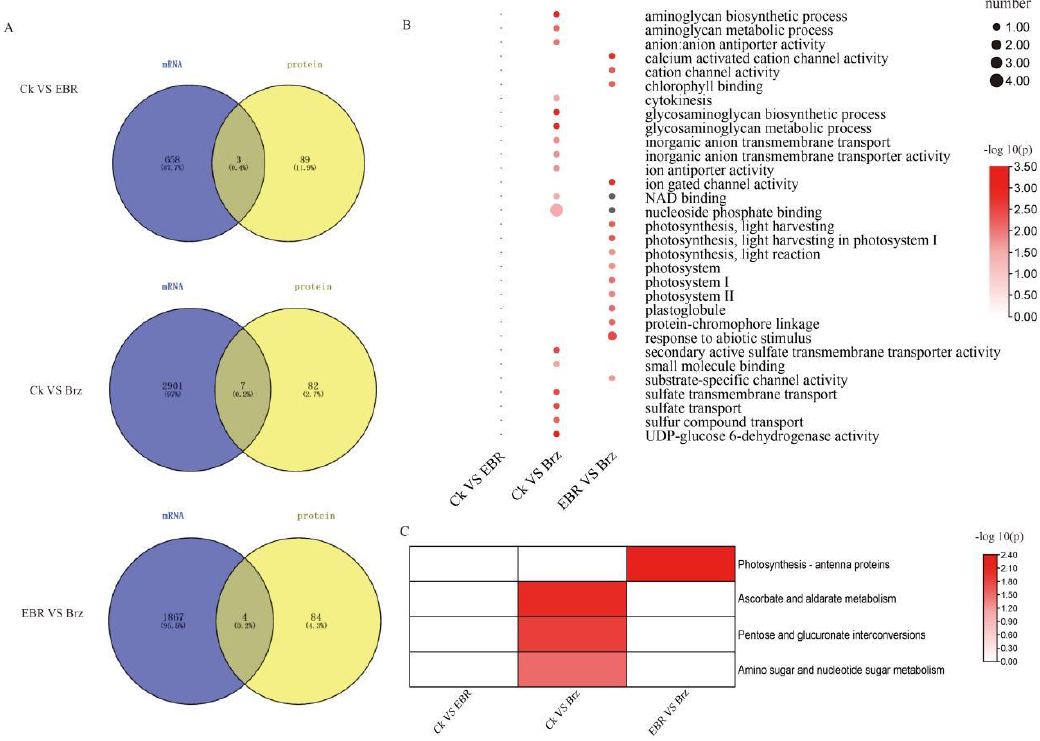
Figure 6. Enrichment analysis of the BR-responsive combined transcriptome and phosphoproteome changes in maize leaves. ( A ) The Venn diagrams of DEPs were analyzed statistically. ( B ) The GO enrichment analysis of the DEPs is shown as a heat map. ( C ) The KEGG enrichment analysis of DEPs is shown as a heat map.